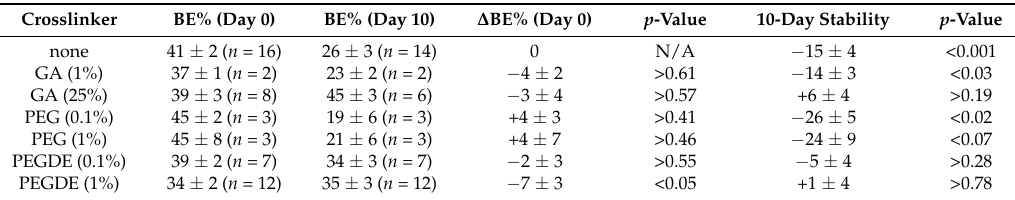
Table 1. BE% (Equation (6)) for the biosensor designs Pt C /PoPD/PEI 2 /GluOx 5 /XL fabricated using a range of crosslinkers (XLs) at different concentrations and crosslinking conditions determined on day 0 and day 10. ∆ BE% (day 0) is the difference in the day-0 BE% value compared with the crosslinker-free design. The 10-day stability value was calculated as the change in BE% on day 10 compared with that of day 0 for each biosensor design. The results for PEGDE crosslinked at room temperature or at 55 ◦ C were statistically the same, and were, therefore,